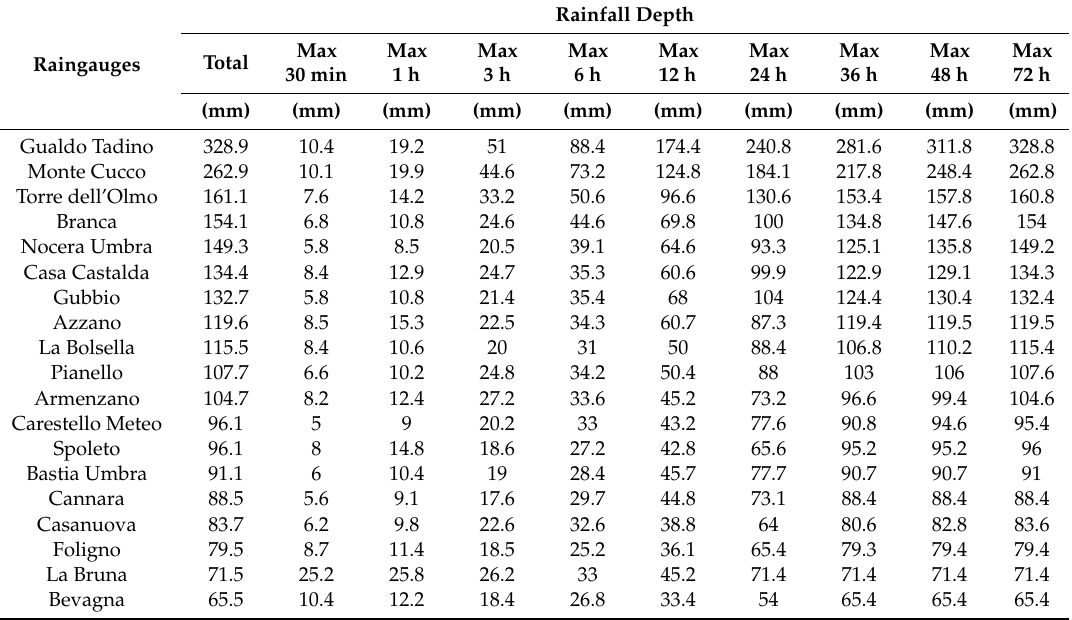
Table 1. Rainfall depths registered at rain gauges for di ff erent time intervals during the flood event occurred on November 2013 in the Chiascio